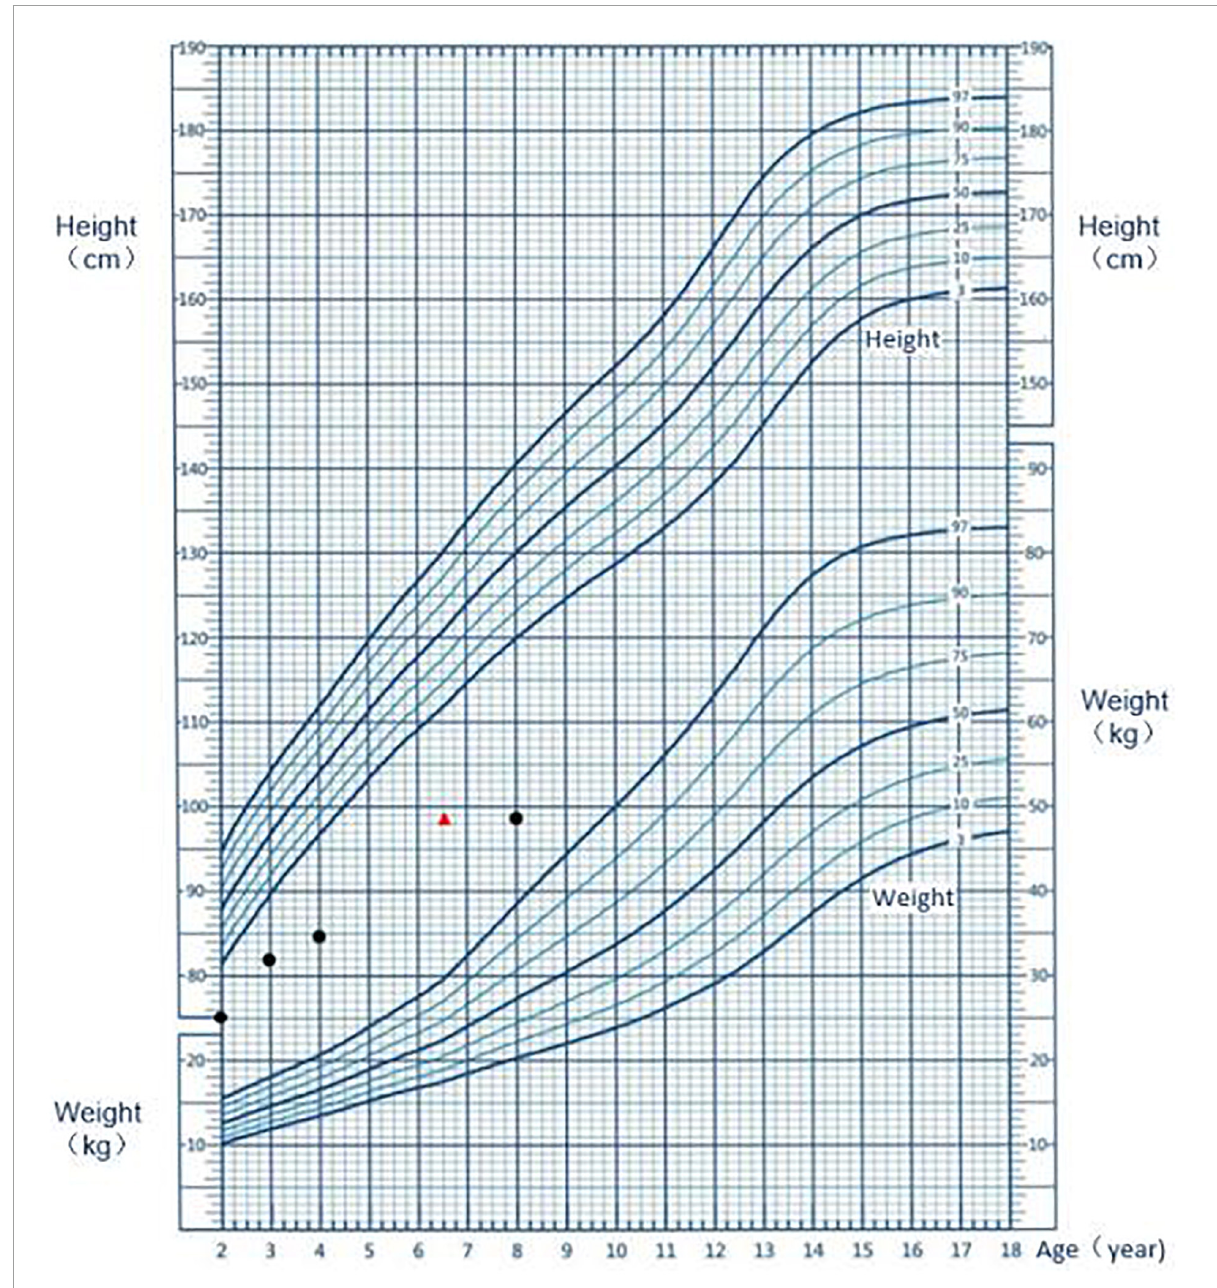
FIGURE1 Growth chart of the patient. The black dot represents the height at the respective age; the red triangle indicates the height at the corresponding bone